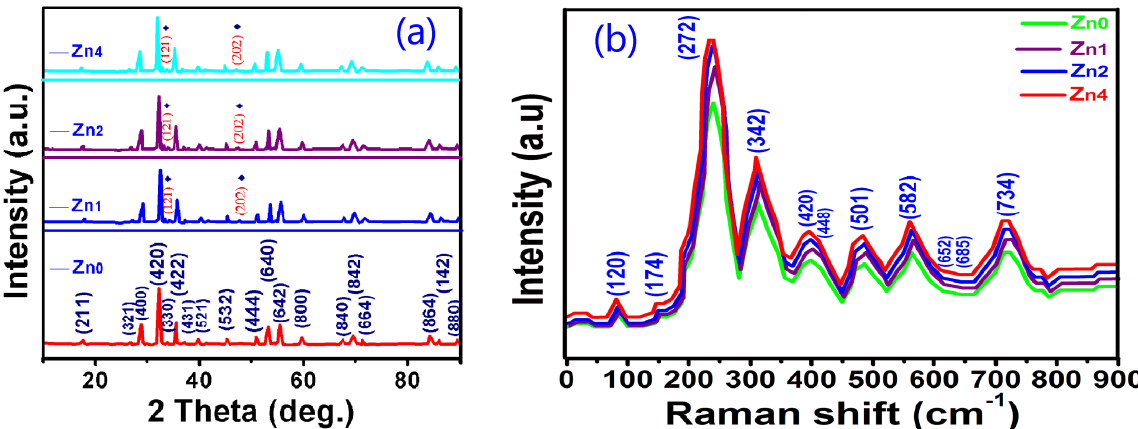
Figure 1. ( a ) XRD patterns and ( b ) Raman spectra of Zn-YIG nanoparticleswith different contents of zinc (0, 0.01, 0.02 and 0.04 wt.%, corresponding to Zn 0 , Zn 1 , Zn 2 and Zn 4 ).